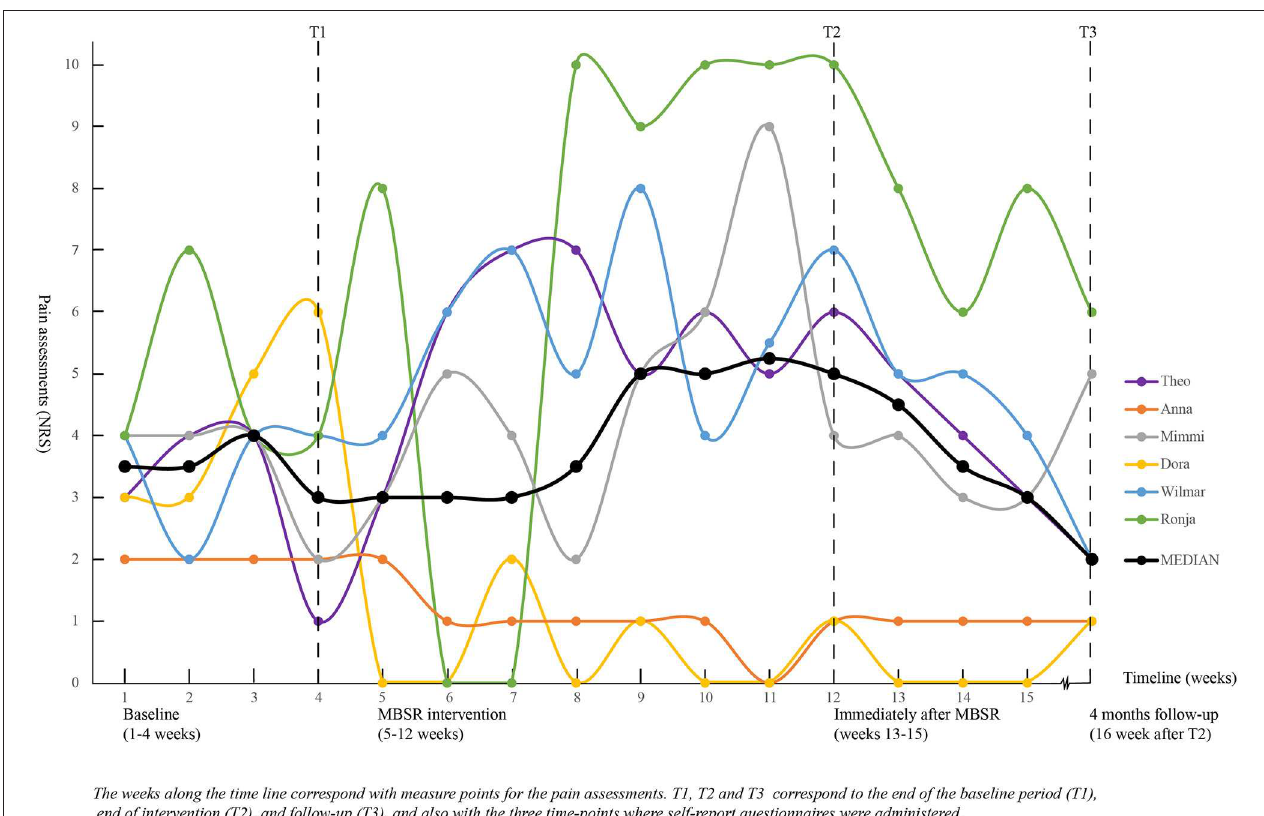
FIGURE 2 | Pain assessment during the study period for all six